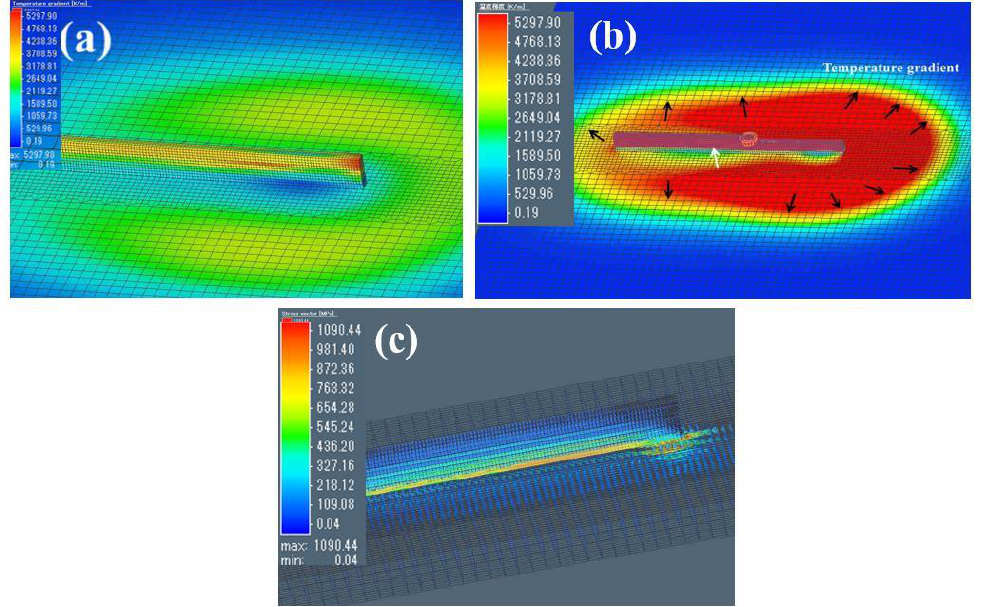
Figure 11. ( a ) The temperature distribution of the thin wall after printing. ( b ) The temperature gradients during the fifth layer’s deposition. ( c ) The residual stress vector and the maximum residual stress at room